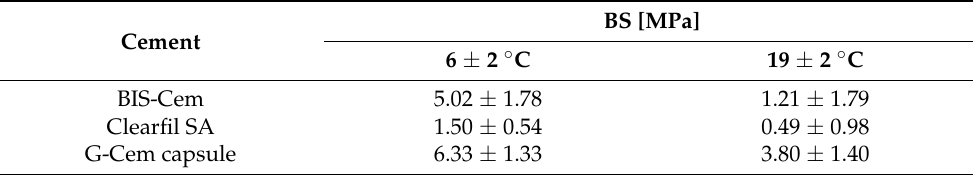
Table 2. The bond strengths (BS) between resin cements and human dentin [MPa] presented in [14].